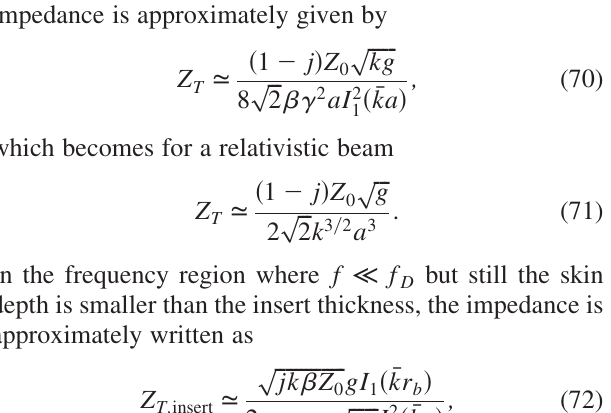
is identical to Eq. (39). The case of t ¼ 10 (cid:13) m where Z wall